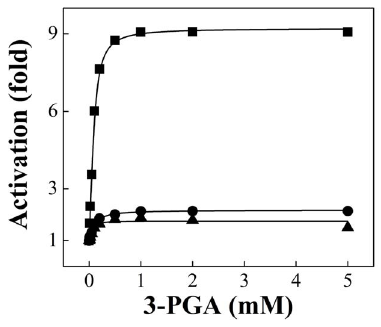
Figure 2. Saturation curves of 3-PGA for the wild type Anabaena ADP-Glc PPase ( & ) and mutants Ana Q58A ( N ) and Ana W96A ( m ). Reactions were performed using Assay A , as stated under ‘‘Materials and Methods’’.